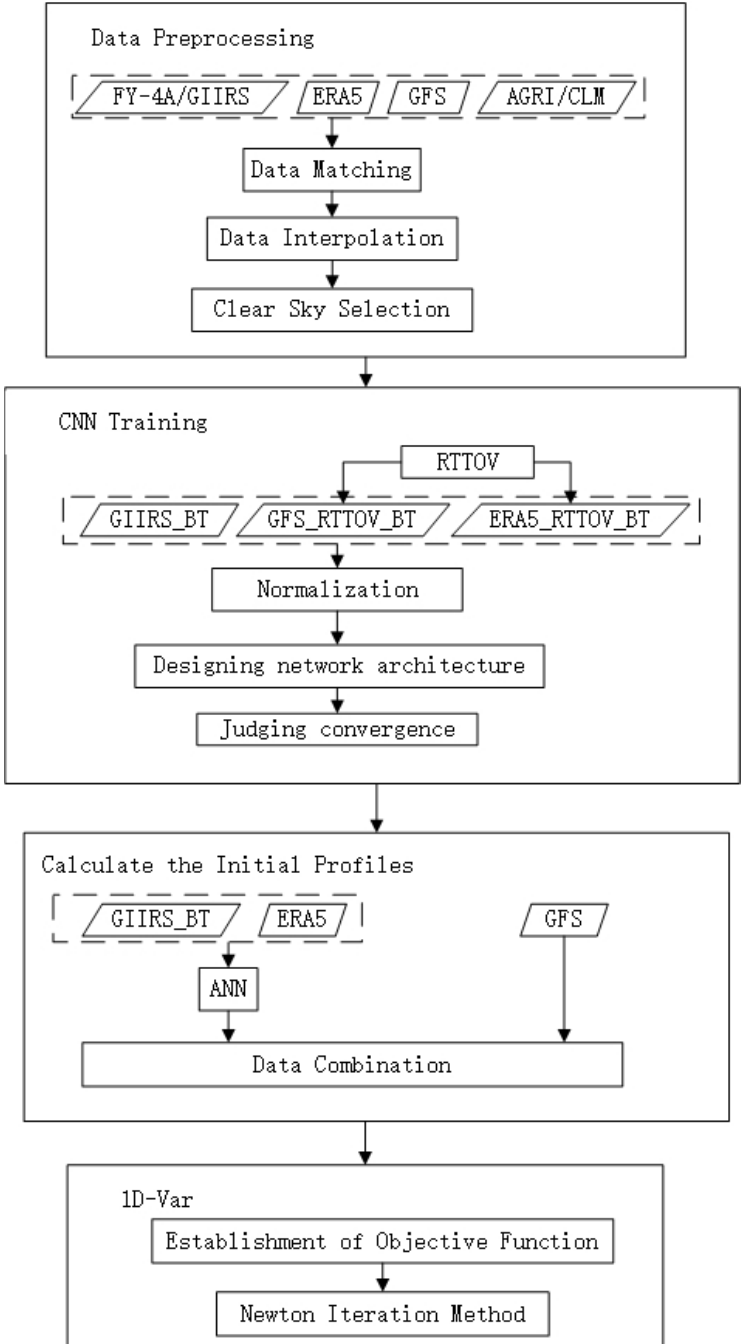
Figure 2. The flowchart of our method.